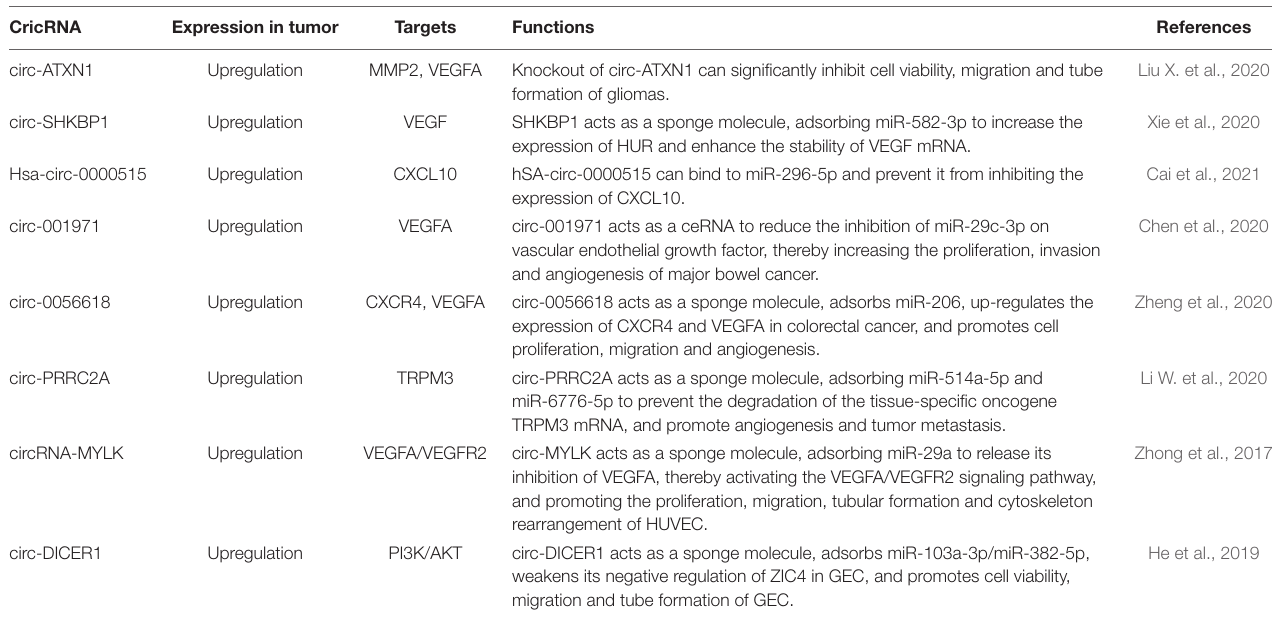
TABLE 3 | Common cricRNA targets and functions in regulating tumor